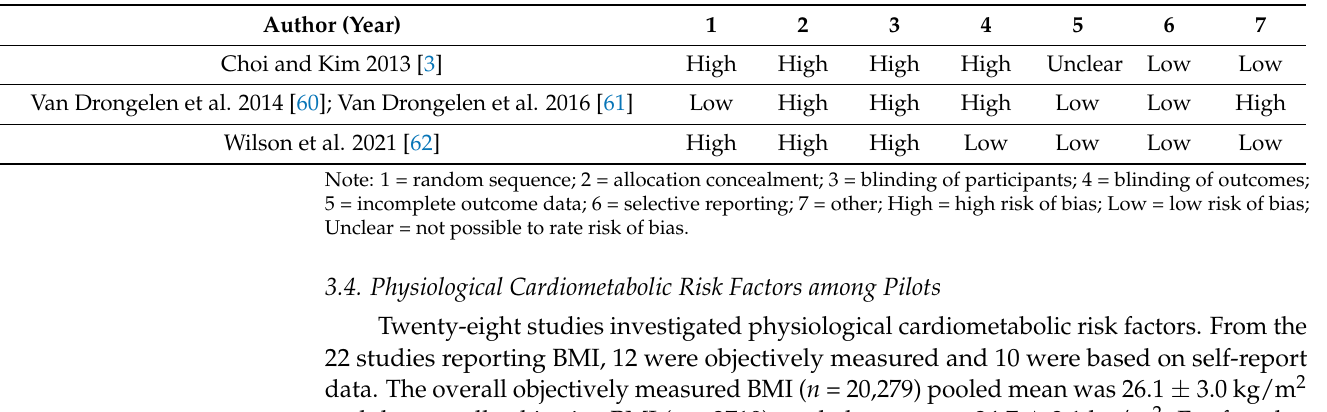
Table 3. Risk-of-bias assessment of clinical